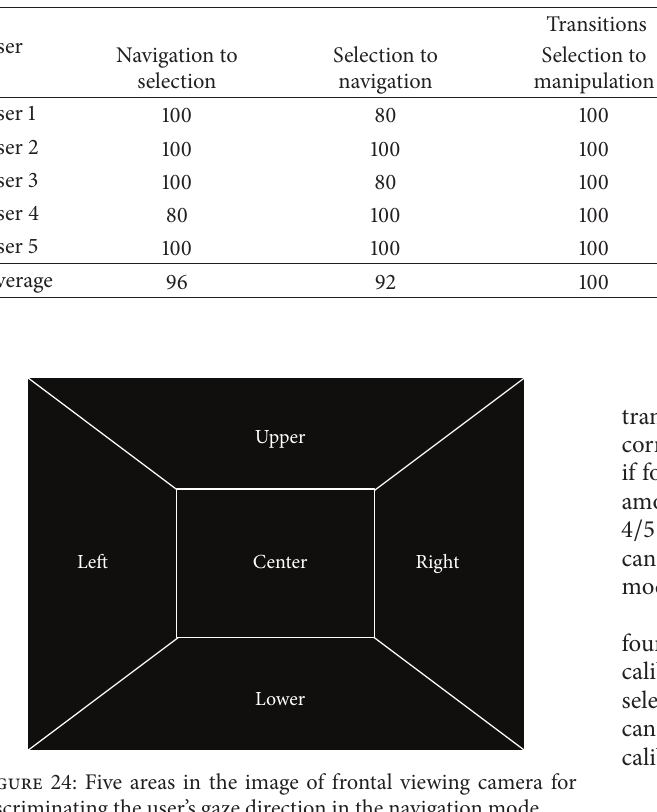
Table 5: Accuracies of trials of transitions between modes (%).